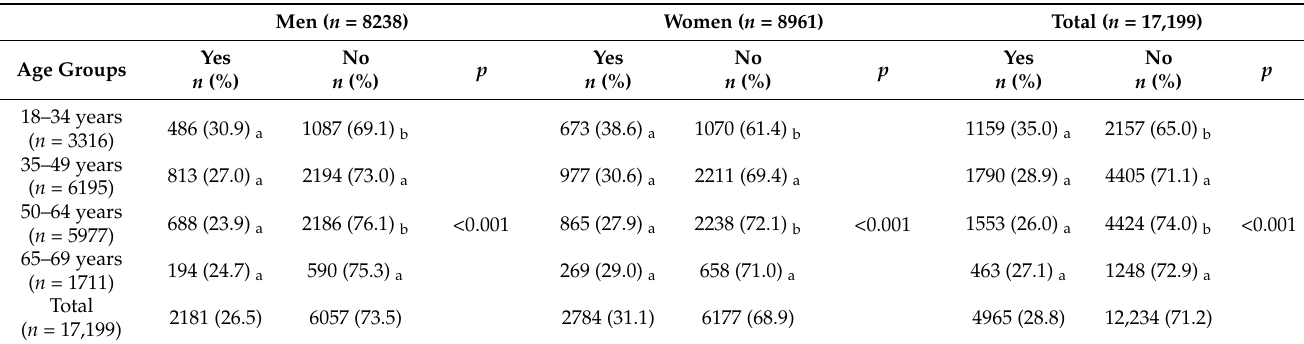
Table 5. Associations between the use of emergency services in the general Spanish population aged 18–69 years, compared by age, according to the ENSE 2017.